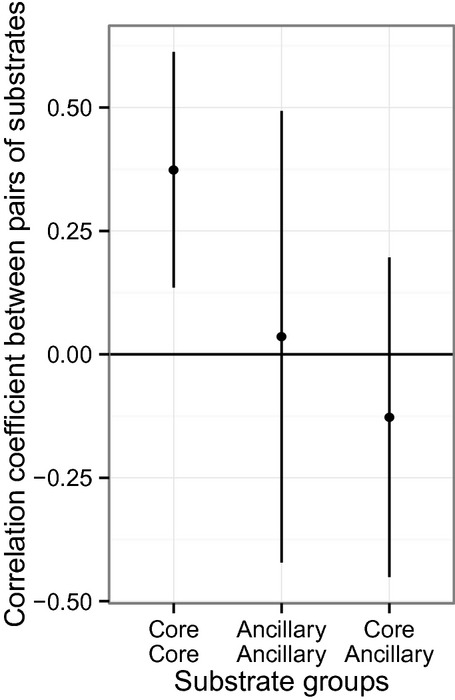
Genetic correlation coefficient between pairs of substrate grouped by diet category (mean value with standard deviation). The core/core and ancillary/ancillary groupings express correlation coefficients between pairs of substrates from the core diet and ancillary diets, respectively, whereas the core/ancillary grouping expresses correlation coefficients between a substrate from the core diet and a substrate in the ancillary diet.